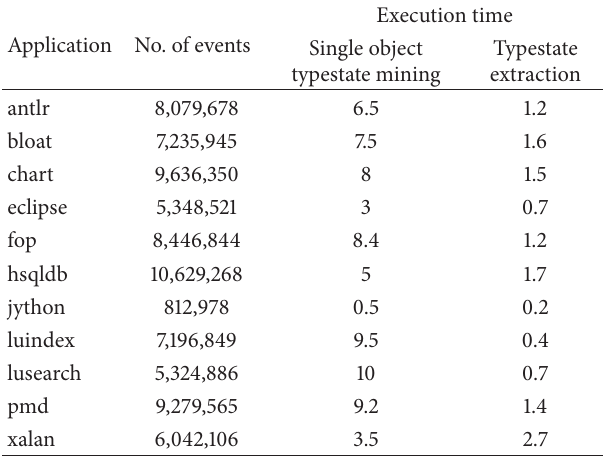
Table 2: Traces used in the experiments and analysis times in min- utes.